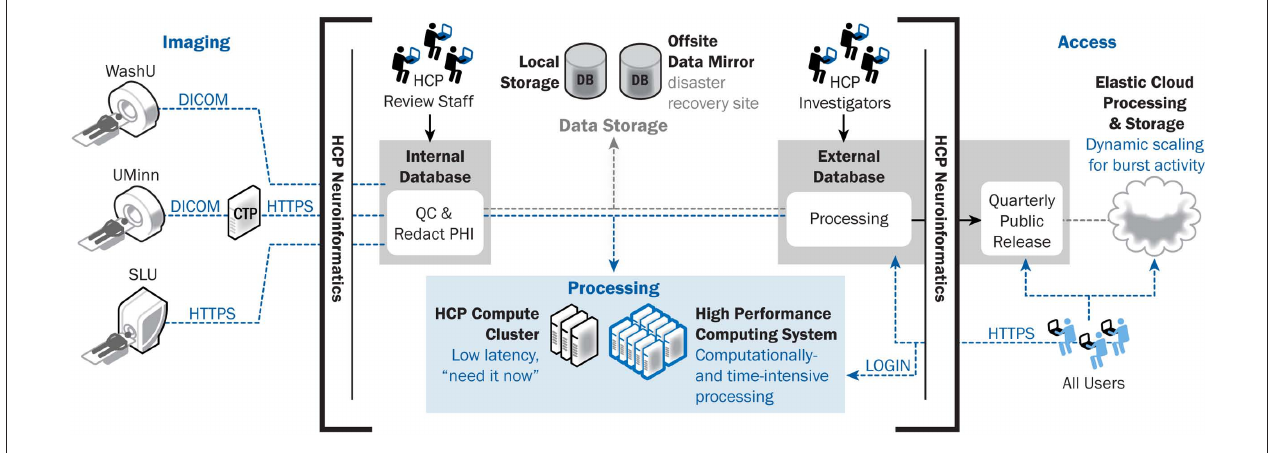
FIguRe 3 | ConnectomeDB architecture, including data transfer components. ConnectomeDB will utilize the Tomcat servlet container as the application server and use the enterprise grade, open source PostgreSQL database for storage of non-imaging data, imaging